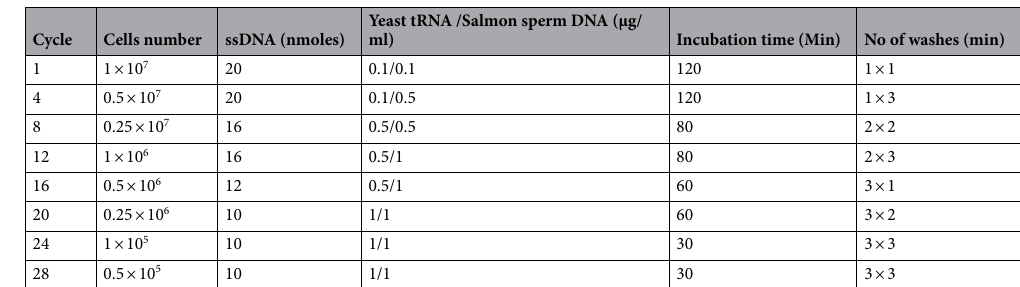
Table 2. Increasing the stringency of selection conditions in cell-SELEX process. USA) followed by desalting with a NAP-5 column (GE Healthcare); the generated FITC-labelled ssDNA pool was lyophilized and used as a pool for following the round of selection. Counter-selection was introduced with Mio-M1 cells from the fifth round and subsequent selection cycles. Briefly, 1 × 10 6 Mio-M1 cells were incubated with the selected ssDNA pool at 4 °C for 30 min with gentle agitation. The unbound ssDNA sequences were then separated by centrifugation at 14,000 rpm for 5 min and subjected to further positive selection. The selection stringency was progressively enhanced to select aptamers that specifi- cally recognize Weri-RB1 cells (Table 2). To monitor the enrichment during Cell-SELEX, 500 nM of FITC-labelled ssDNA pools were incubated with the 2 × 10 5 Weri-RB1 and Mio-M1 cells (dissociated with non-enzymatic dissociation buffer) in 500 μL of BB at 4 °C for 30 min after washing once with 1X PBS and twice with WB. After incubating the enriched pools, the cells were washed three times with WB and analysed by flow cytometry (BD FACS Accuri). The FITC-labelled ssDNA library was used as a negative control. All experiments were repeated three times. A total of 30 rounds of selection were performed before sequencing the pools. After confirming the saturation of enrichment by FACS, the enriched pools were sent to Base Pair Biotechnologies (Texas, US) for Next-Generation Sequencing. The top 20 oligonucleotide sequences were further evaluated by phylogeny and the number of repeats in each family. The Geneious software was used to construct a phylogenetic tree with the Tree Builder function. The tree distances and sequence relatedness were determined by the method of Tamura and Nei using a neighbour-joining model without any outgroup. The secondary structure and free energy (Delta-G) of shortlisted aptamers were calcu- lated using the M-fold web server (http:// www. unafo ld. org/ mfold/ appli catio ns/ dna- foldi ng- form. php), finding the optimal structure for each aptamer. The conditions used for the structure predictions were set according to the constituents of the BB at 37 °C in 200 mM Na + and 0.5 mM Mg 2+ at pH 7.4. Sequence homology analysis by MEME online software (https:// meme- suite. org/ meme/ tools/ meme) to find out the homology between the sequences and identify the possible binding motifs. Binding assays. To evaluate the binding efficiency of selected aptamers, 250 nM of FITC-labelled aptamers were incubated with 5 × 10 5 Weri-RB1 and Mio-M1 cells on ice for 30 min. Samples were washed three times with 0.5 mL of WB, resuspended in 0.5 mL of 1X PBS or BB and analysed by the BD FACS Lyric cytometer. The initial FITC-labelled ssDNA library and unstained cells served as controls. To determine the equilibrium dissociation constant 5 × 10 5 Weri-RB1 and Mio-M1 cells were incubated with varying concentrations (0 to 500 nM) of FITCl-abelled aptamers in 200 μL of BB on ice for 60 min in the dark with gentle shaking. Cells were then washed thrice with 0.5 mL of WB, re-suspended in 0.5 mL of BB, and sub- jected to flow cytometric analysis. The ssDNA library was used as the negative control. The mean fluorescence intensity of each sample was subtracted from the mean fluorescence intensity of the background produced by the ssDNA library. The equilibrium dissociation constant (Kd) of the aptamer–cell interaction was obtained using GraphPad Prism (GraphPad Prism version 7.00 for Windows) by fitting the dependence of fluorescence intensity of specific binding on the concentration of the aptamers to the equation: where, Y is fluorescence intensity of cells, X is concentration of the aptamer and B max is maximum binding potential. To determine the specificity of the selected aptamer, the binding assay of VRF-CSRB-01 with four other RB cell lines (Y79, NCC-RbC39, NCC-RbC51, and NCC-RbC60), and normal ocular cell lines, retinal pigmental epithelial cell line (ARPE-19) and corneal epithelial cell line (HCE-02) was analysed by flow-cytometry. To check the effect of temperature on the binding affinity, Weri-RB1 cells were incubated with 250 nM VRF- CSRB-01 at 25 °C and 37 °C for 30 min, while aptamers incubated on ice were used as the positive control and the ssDNA library as a negative control, followed by flow-cytometric analysis. To perform a target-type analysis, Weri-RB1 cells were treated with a 0.1 mg/mL Proteinase K (Sigma) or 0.25% trypsin (Gibco) solution for 5 min at 37 °C. The reaction was stopped by adding 5 ml of RPMI with 20% (v/v) of FBS. Then, cells were washed twice and incubated with 250 nM of VRF-CSRB-01 for 30 min and ana- lysed by flow-cytometry.